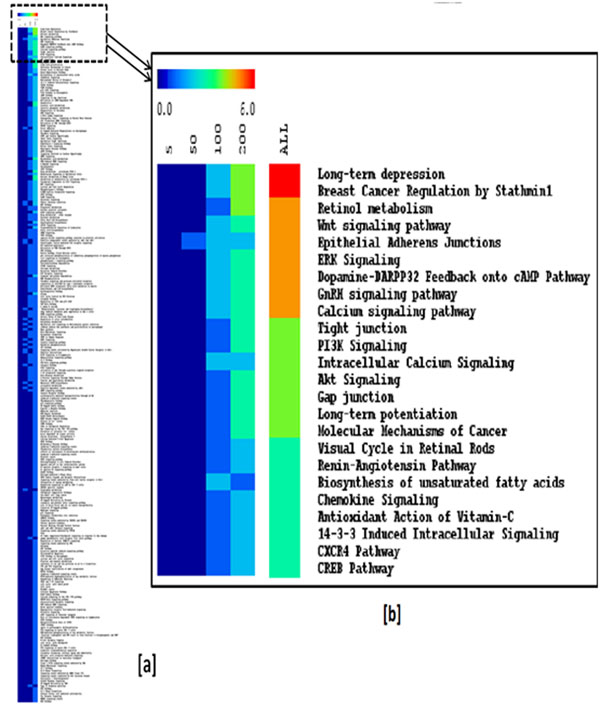
Protein frequency count matrix (PPFCM) generated using differentially expressed genes at three doses of 2,4DNT treatment [a] 266 pathways in the pathway. The vertical axis contains pathways from the Human Pathway Database (ref) pathways and doses, rounded to nearest whole number, on the horizontal axis. Each cell of PPFCM corresponds to the count of proteins at a particular dose for a given pathway. [b] Snapshot of top 25 pathways. The pathways are ranked in a descending manner based on the sum of DEGs at ‘ALL’ doses.